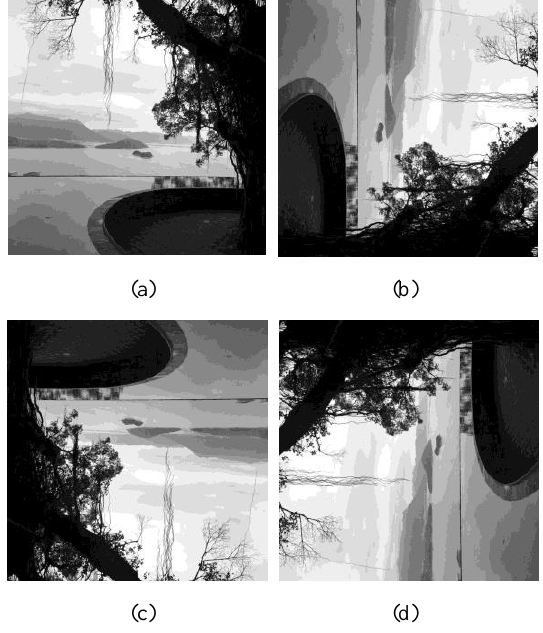
Figure 17 grayscale images with the same composition information (i.e., same Shannon entropy values), but different configurational information.